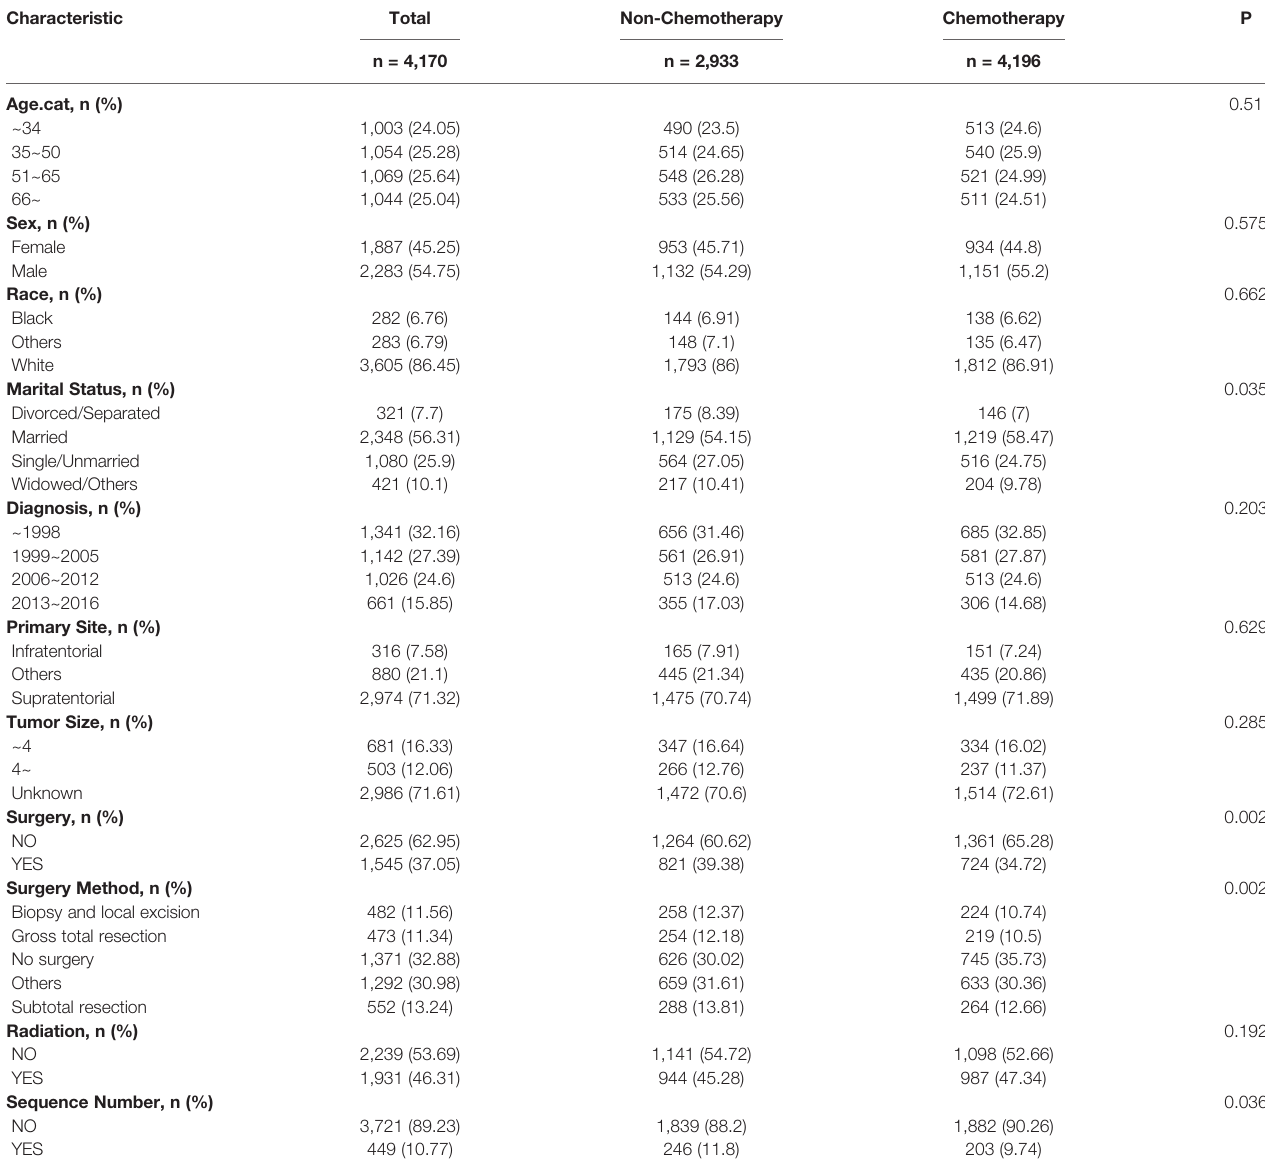
TABLE 2 | The demographic characteristics of anaplastic astrocytoma patients after PSM. Characteristic Total Non-Chemotherapy